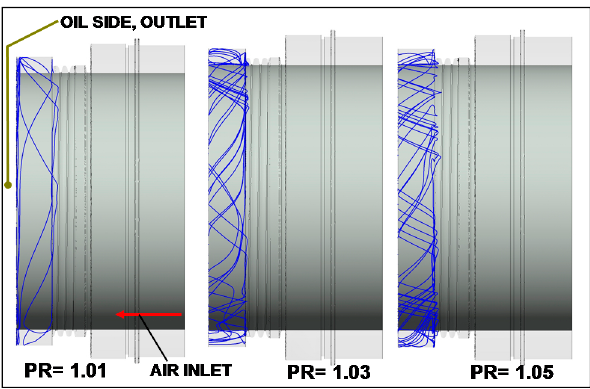
Figure 16. Oil trajectories at 15,000 rpm, three different pressure ratios, s = 0.3 mm, smooth rotor.